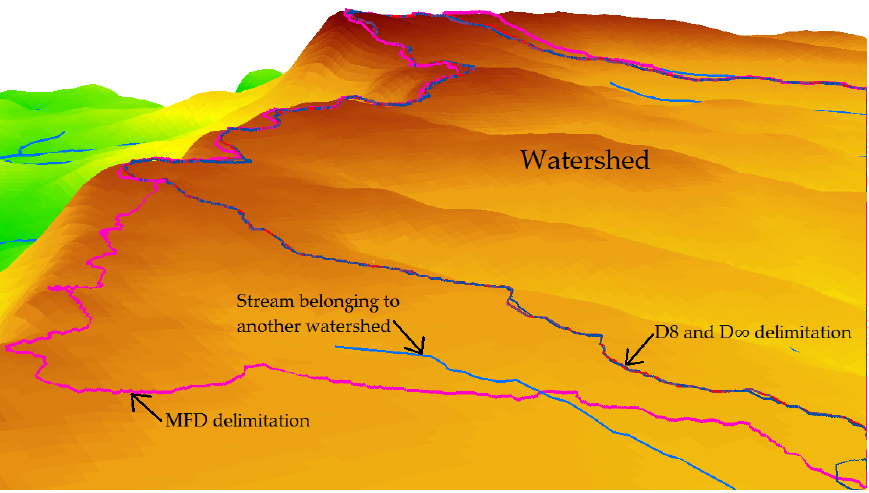
Figure 5. Accomplished delimitations by the D8, D ∞ , and MFD algorithms over the merged DEM, including part of the hydrography.